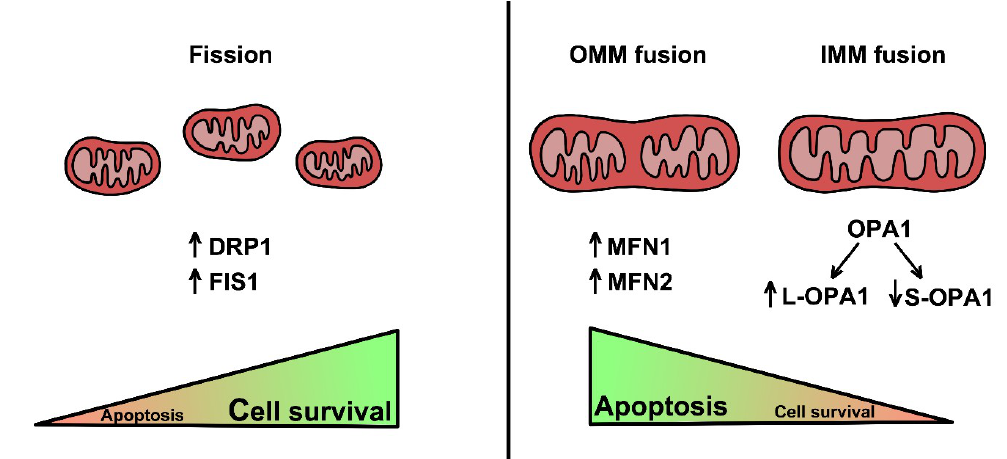
Figure 1. Mitochondrial fission is mainly mediated by DRP1 and FIS1 proteins, associated with increased aerobic glycolysis. This peculiar metabolic asset is typical of tumor cells to support their metabolic demands and their survival. On the other hand, elongation of mitochondria is a two‐step event mediated by MFN proteins and OPA1. MFN1 and MFN2 participate in outer mitochondria membrane fusion, while one of OPA1 isoforms (L‐OPA1) promotes IMM fusion. Conversely, another OPA1 isoform (S‐OPA1) mediates to the opposite trend. Table 1. Activities played by mitochondrial fusion and fission regulators in di ff erent kind of tumors. Gene Biological Function Role in Cancer